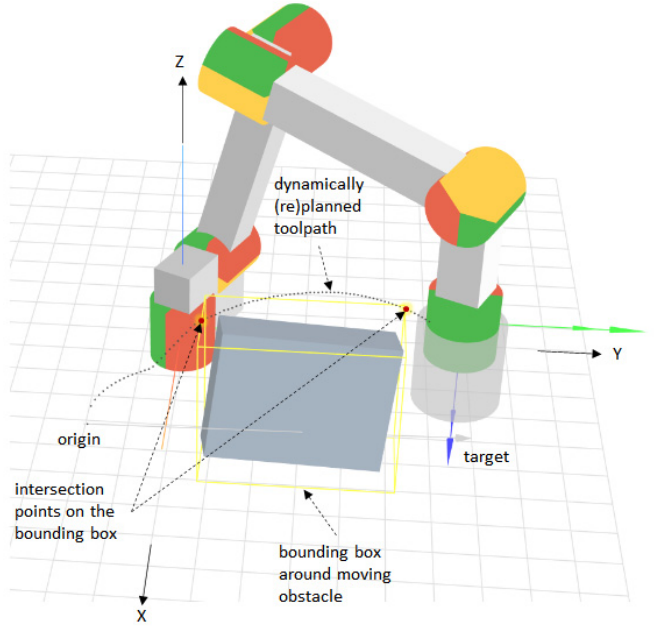
Figure 4. Dynamic path planning with obstacle avoidance.